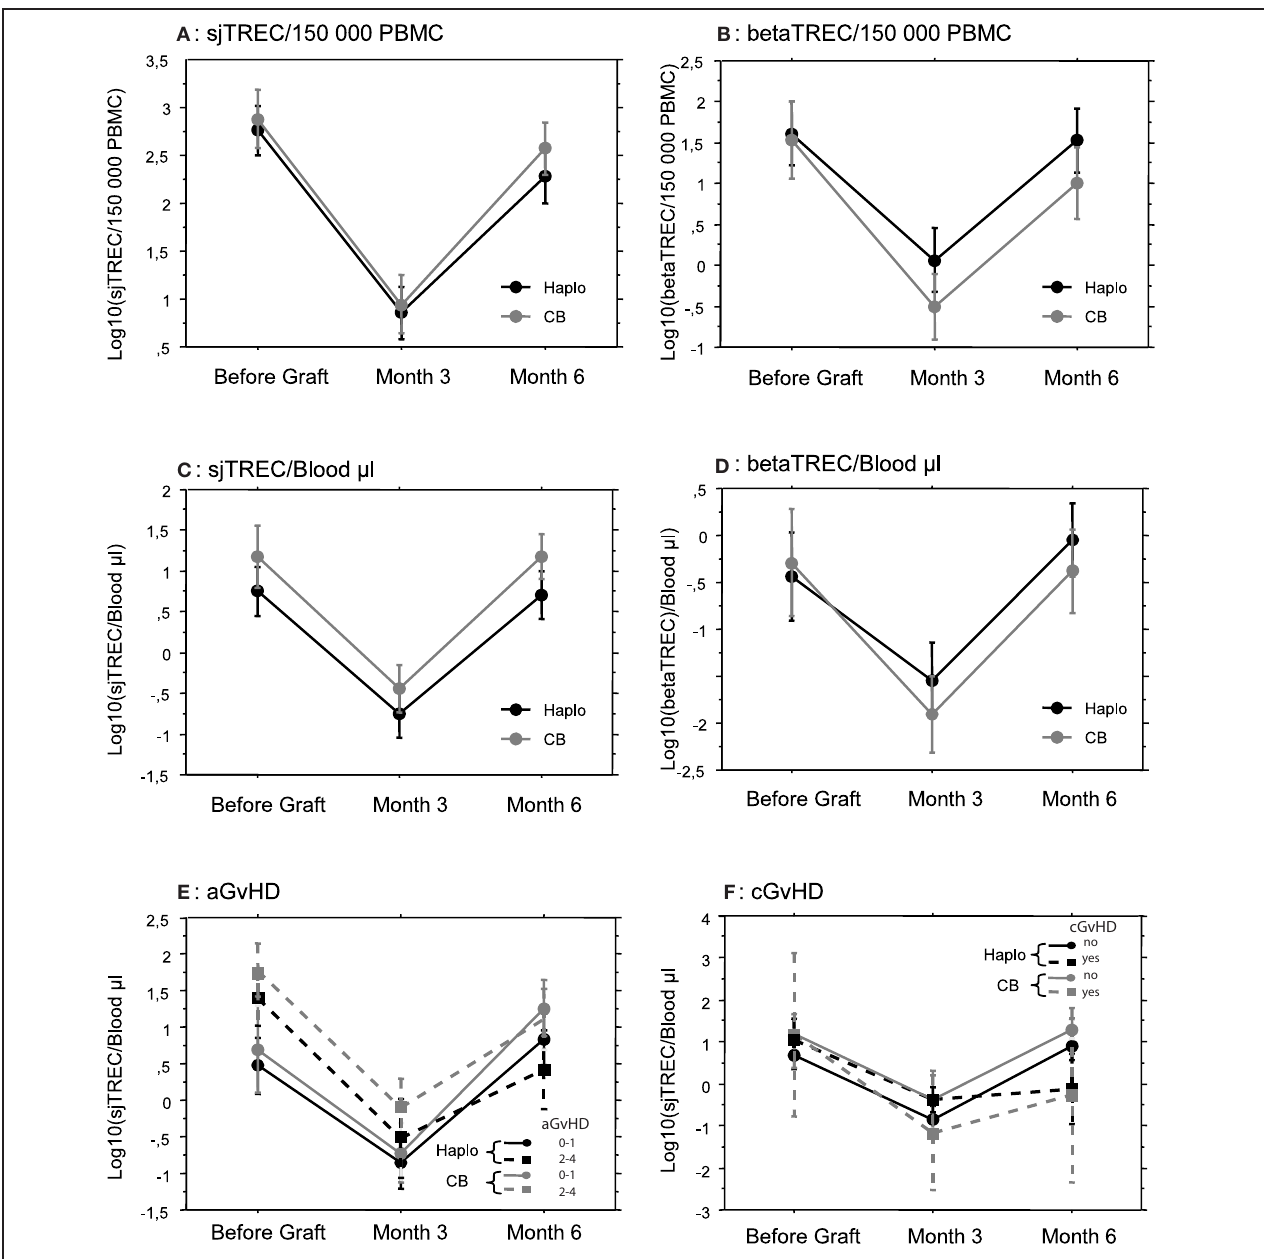
FIGURE 1 | Thymic reconstitution is not dependent on the stem cell source employed or GvHD occurrence. Mean ( ± SE) number of log10 TREC was measured by quantitative PCR, before, and 3 and 6 months after transplantation in patients that received either a haploidentical hematopoietic Stem Cell Transplantation (Haplo, N = 33) or a Cord Blood Unrelated Donor